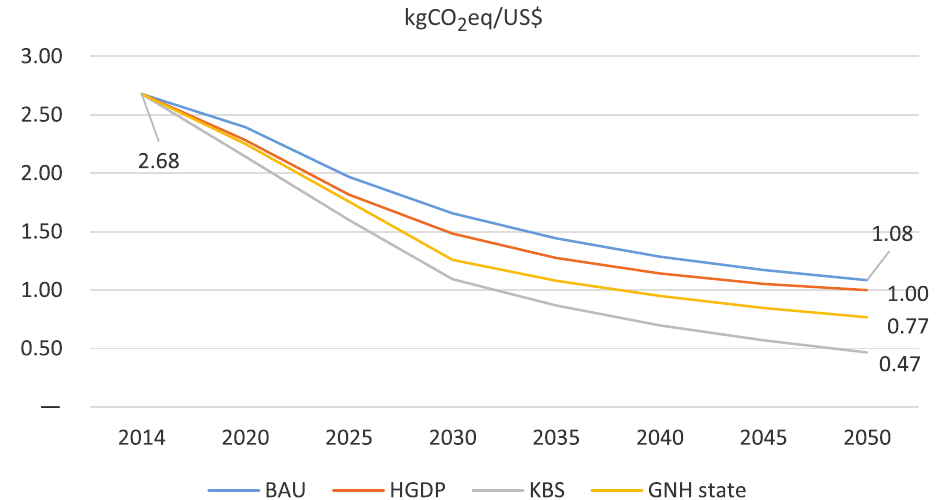
Figure 5. Carbon intensity of the Bhutanese economy.